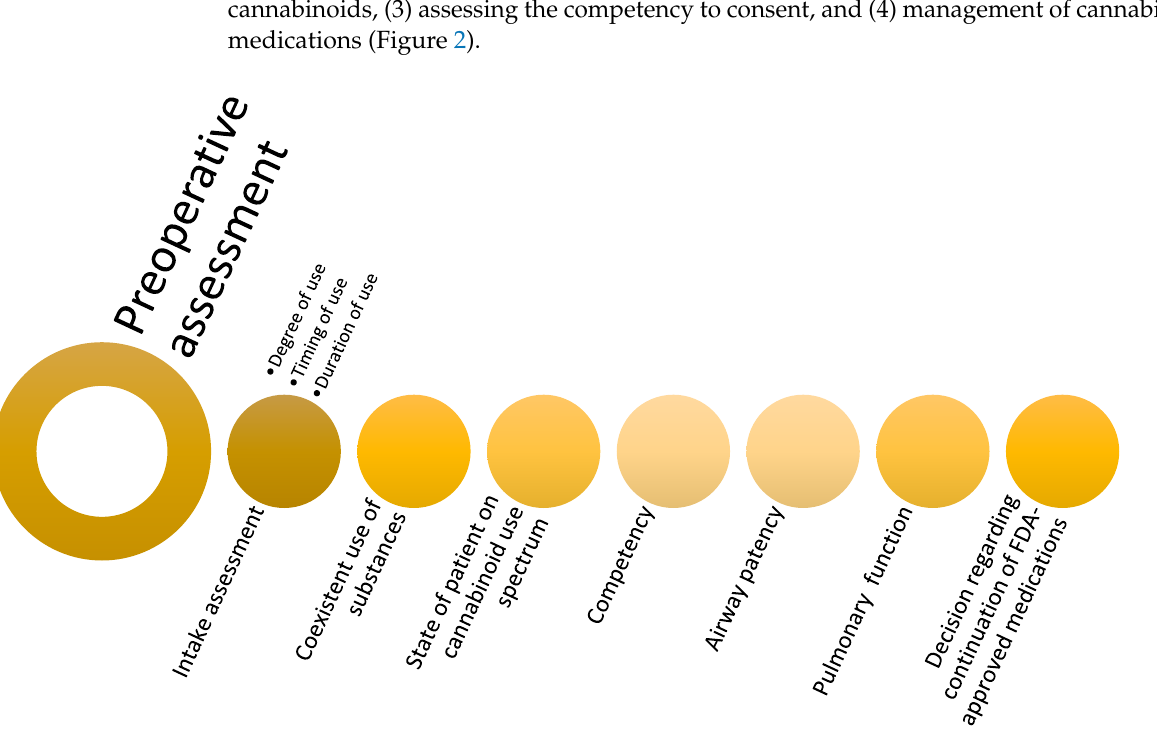
Figure 2. Preoperative consideration in anesthesia in an individual with cannabinoid intake.